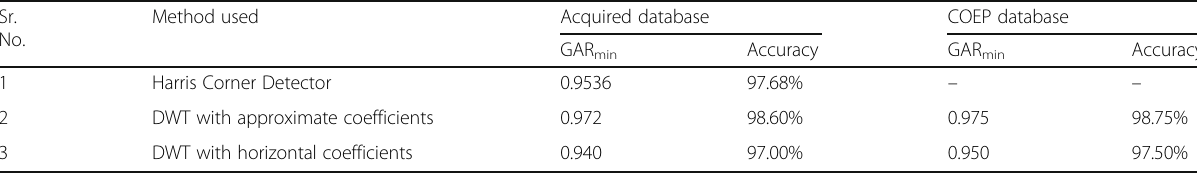
Table 1 Comparison using three feature extraction techniques Sr.